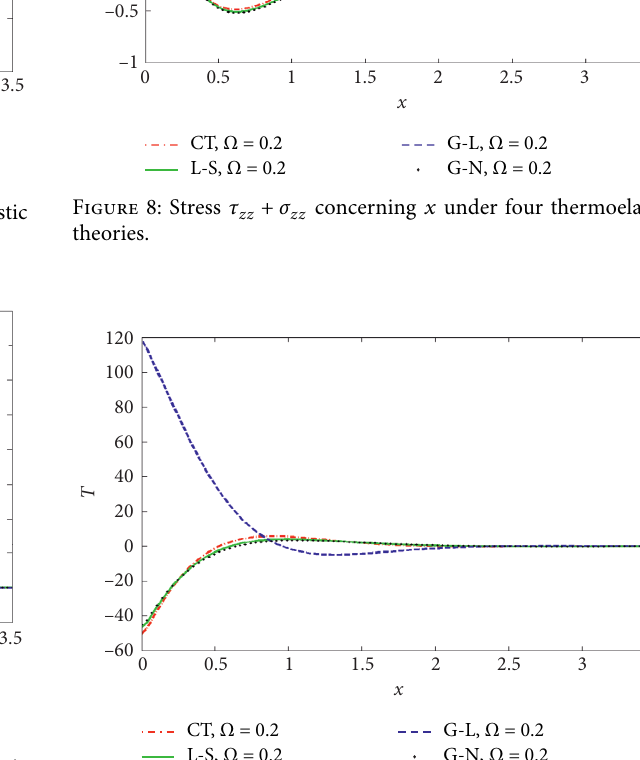
Figure 6: Stress σ x under four thermoelastic xz concerning theories.